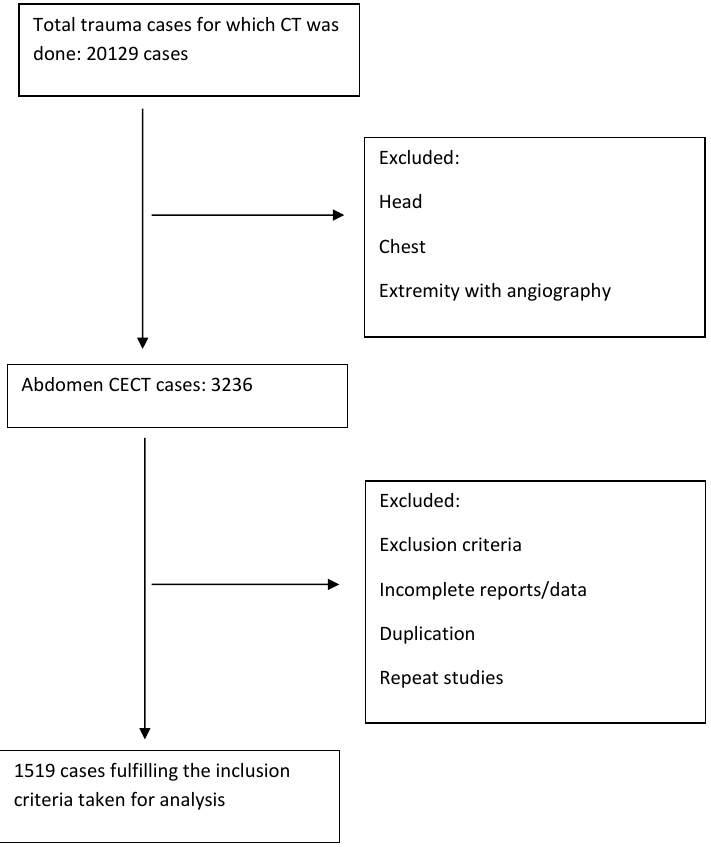
Figure 1. Flow chart of the study.